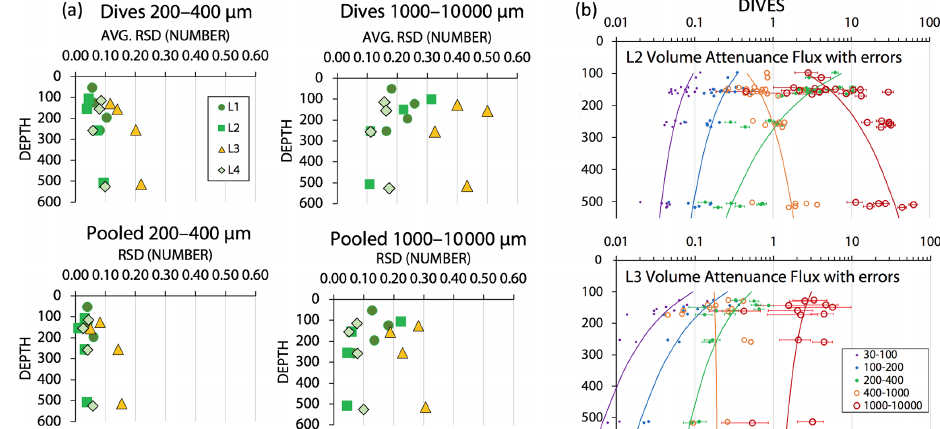
Figure A5. (a) Analysis of statistical counting errors for particles in the 200–400 and 1000–10000µm size categories. The graphs depict averaged relative standard deviations (RSD) for individual dives and for pooled data at four depth horizons. (b) We illustrate the contribution of statistical counting error and 9% calibration uncertainty to VAF for the 200–400 and 1000–10000µm size categories at L2 and L3. In this case counting errors were based on numbers of particles for each dive. At L2, the contribution of error was a small fraction of the natural variability of > 1000µm VAF results.